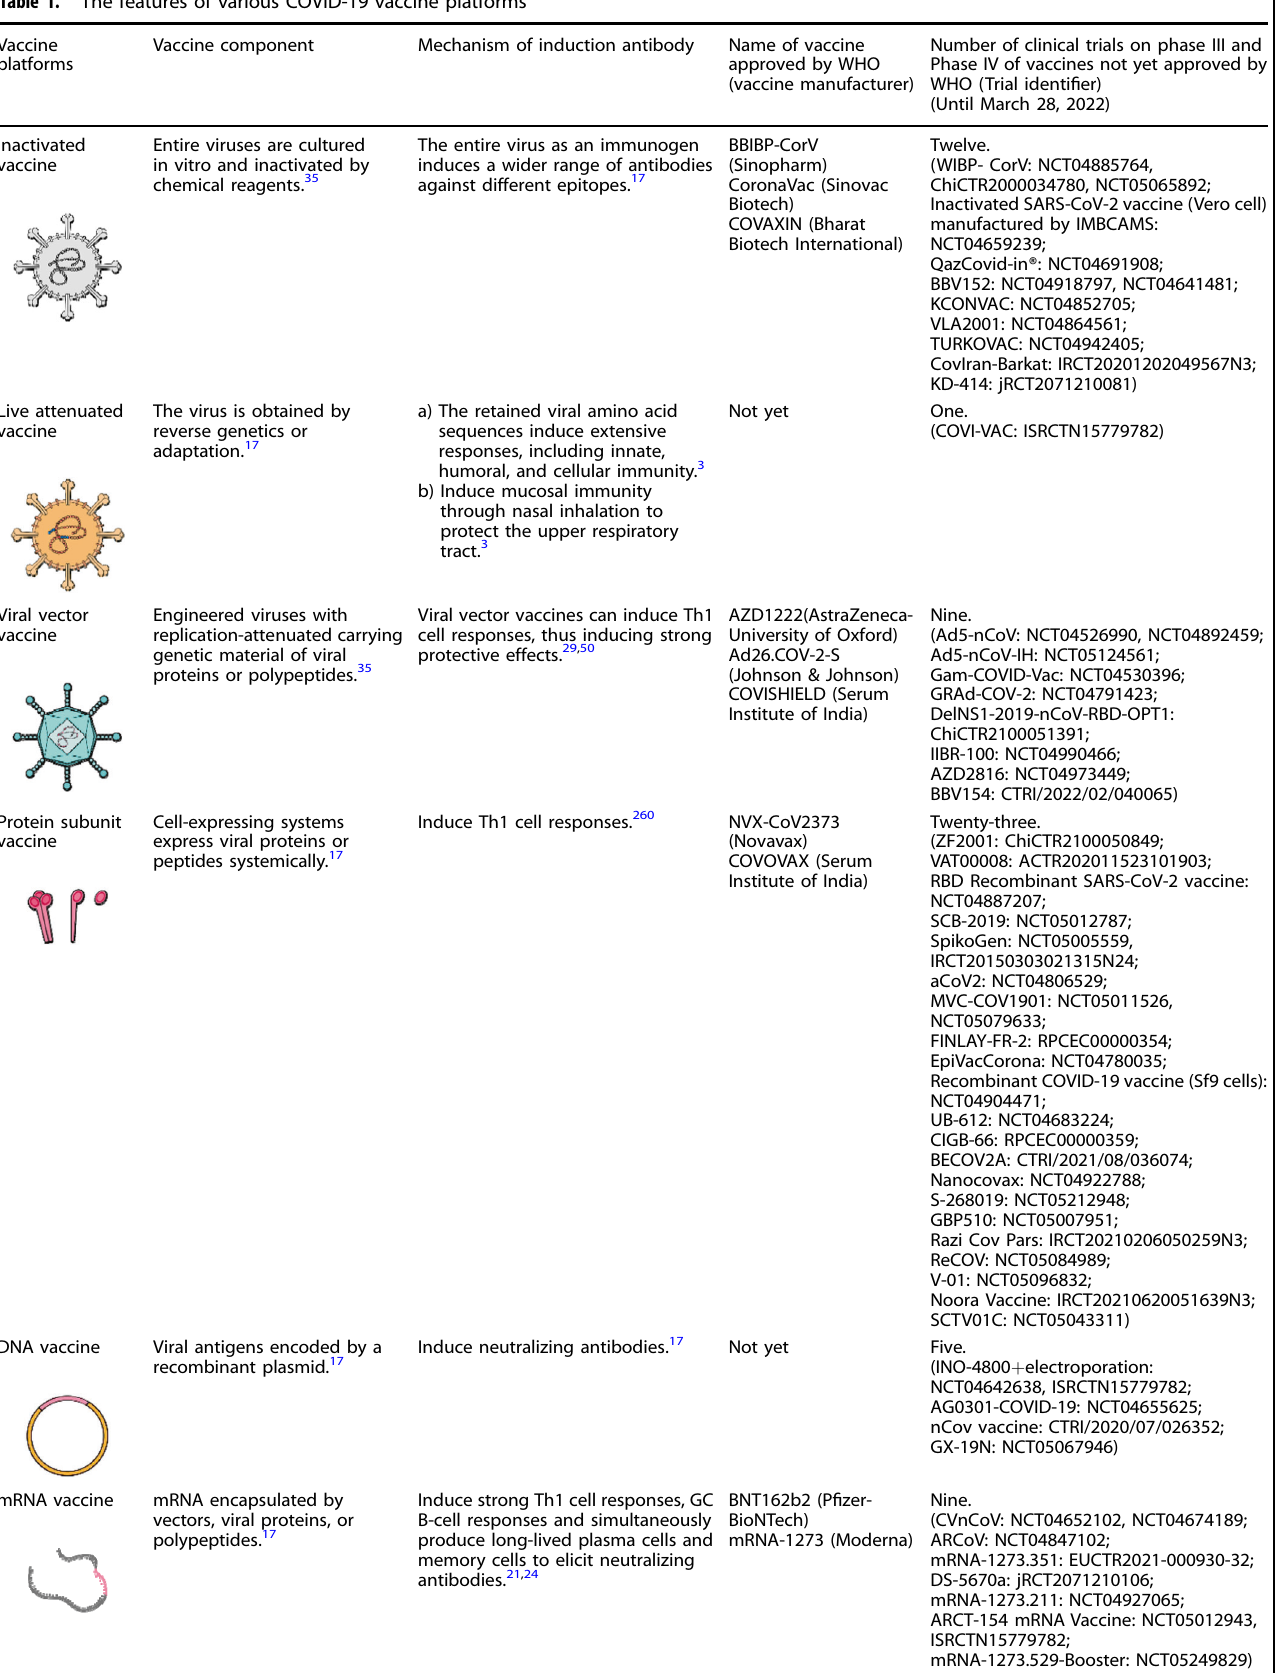
Table 1. The features of various COVID-19 vaccine platforms Vaccine